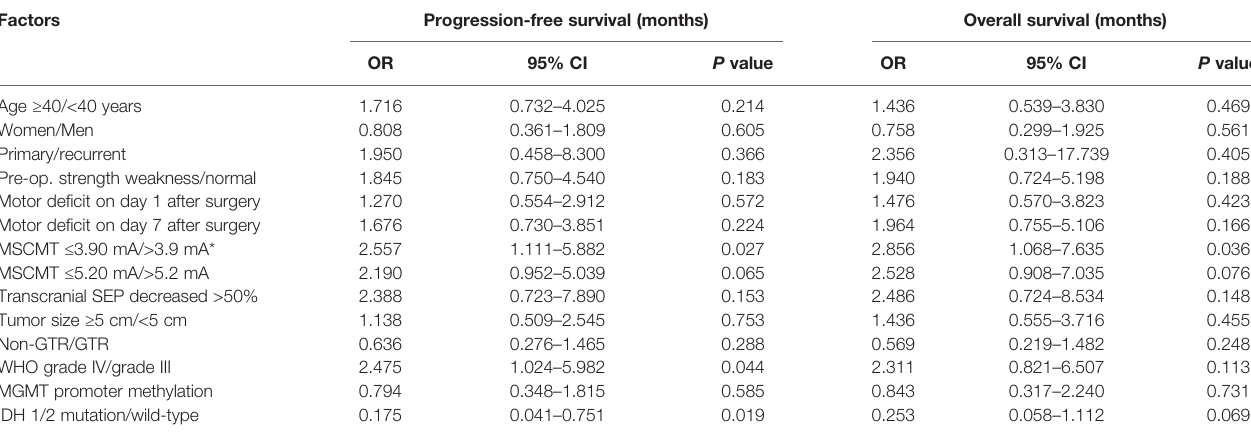
TABLE 2 | Factors correlated with PFS and OS in high-grade gliomas (n = 42). Factors